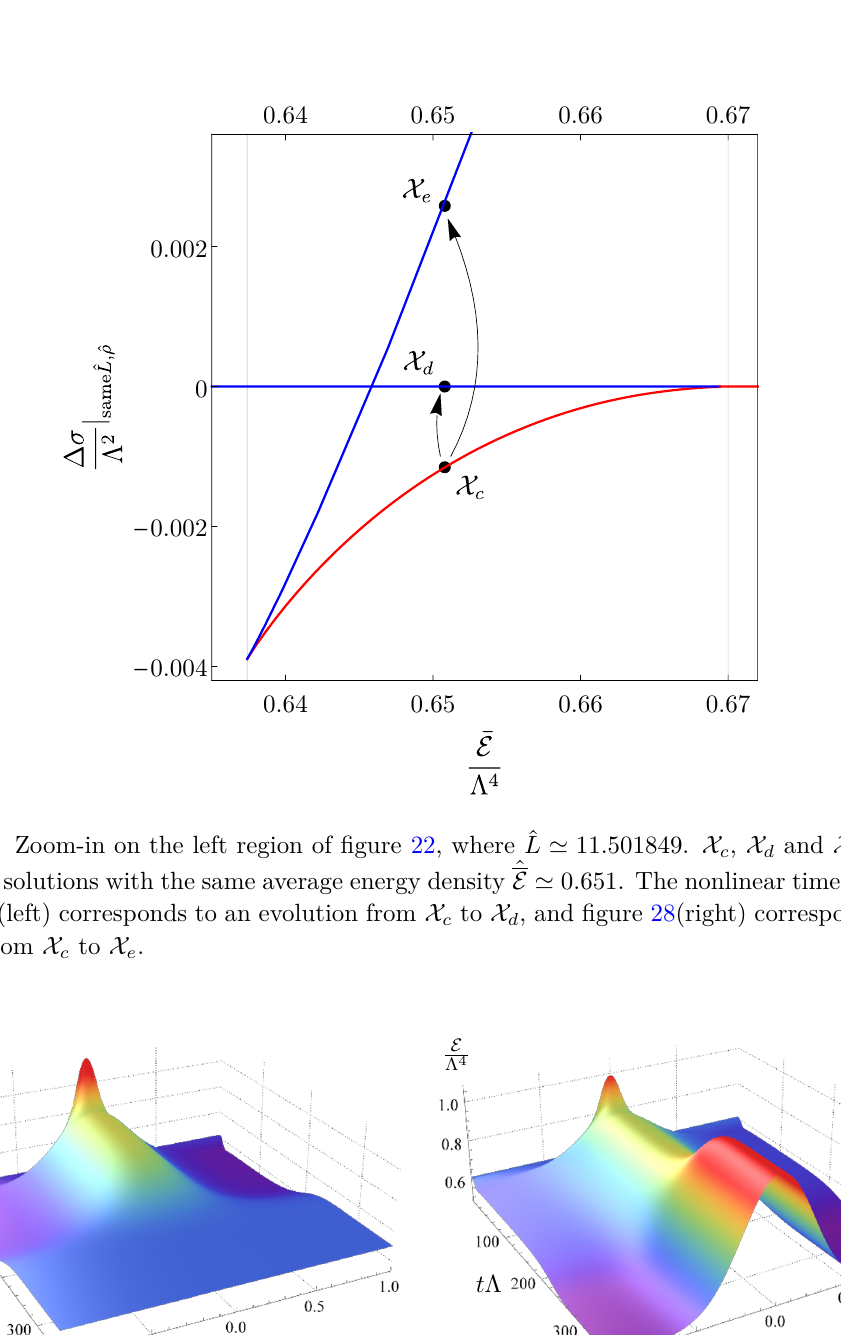
Figure 28 . Extension to longer times of the time evolution shown in figure 24(bottom-left), whose initial state is a homogeneous configuration plus a large perturbation of amplitude A . At intermediate times this generates the unstable solution X c plus a small perturbation. (Left) If the amplitude of the initial perturbation A is slightly smaller than the critical value A ∗ then the system eventually evolves back to the homogeneous solution labelled as X d in figure 27. (Right) If the amplitude of the initial perturbation A is slightly larger than the critical value A ∗ then the system eventually evolves towards the stable, inhomogeneous solution labelled as X e in figure